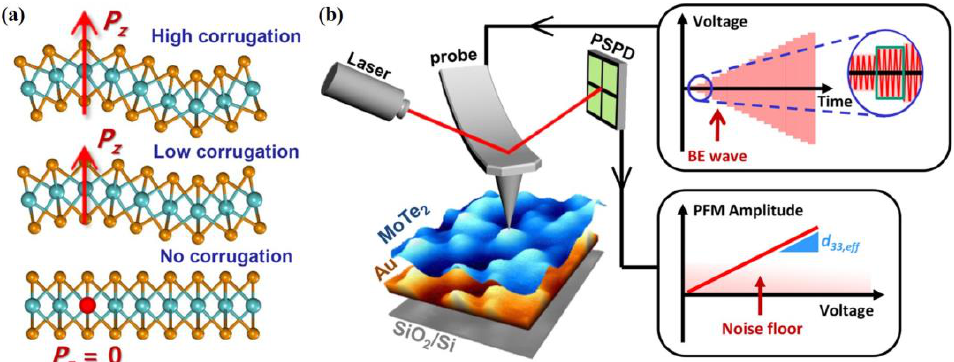
Figure 12. ( a ) The different degrees of corrugation engineering [118]. Reprinted with permission from [118]. Copyright 2018 American Chemical Society. ( b ) The deformation of MoTe 2 film driven by Au fold was observed by atomic force microscopy (AFM). Waveform diagram of band excitation (BE) with Vac. The relationship between the amplitude of piezoelectric response force microscope (PFM) and the magnitude of alternating current (AC) voltage [118]. Reprinted with permission from [118].